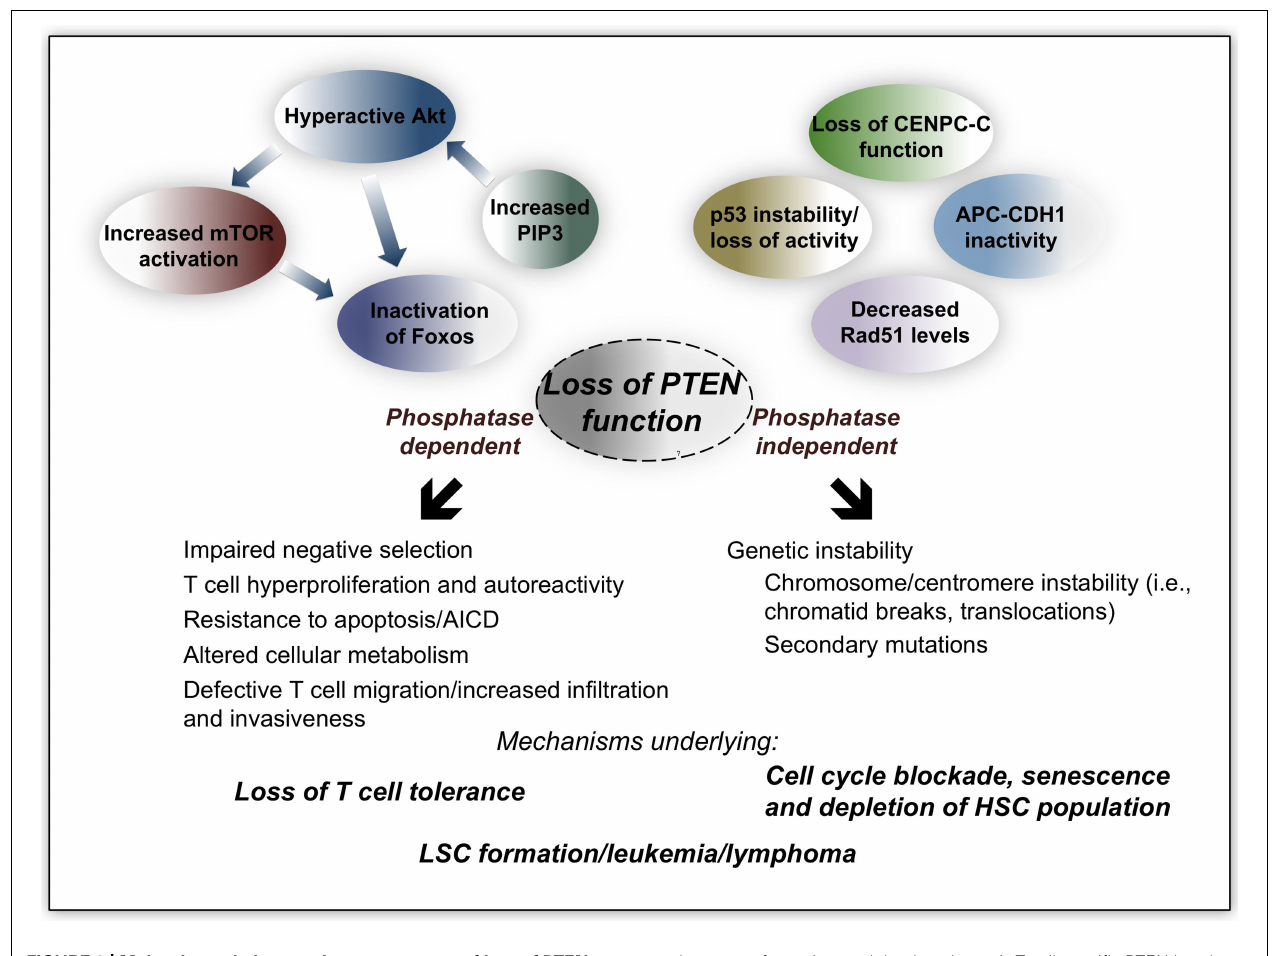
FIGURE 2 | Molecular and phenotypic consequences of loss of PTEN phosphatase-dependent and -independent functions during hematopoiesis and within theT cell compartment. Loss of PTEN phosphatase activity results in increased levels of PIP3, causing hyperactivation of the Akt pathway and subsequent activation of the mTOR pathway, and inactivation of the Foxo family of transcription factors. Disruption of PTEN phosphatase-independent function accounts for loss of much of its nuclear activity, compromising genetic stability and DSB repair, leading to chromatid breaks and translocations.That matureT cells do not